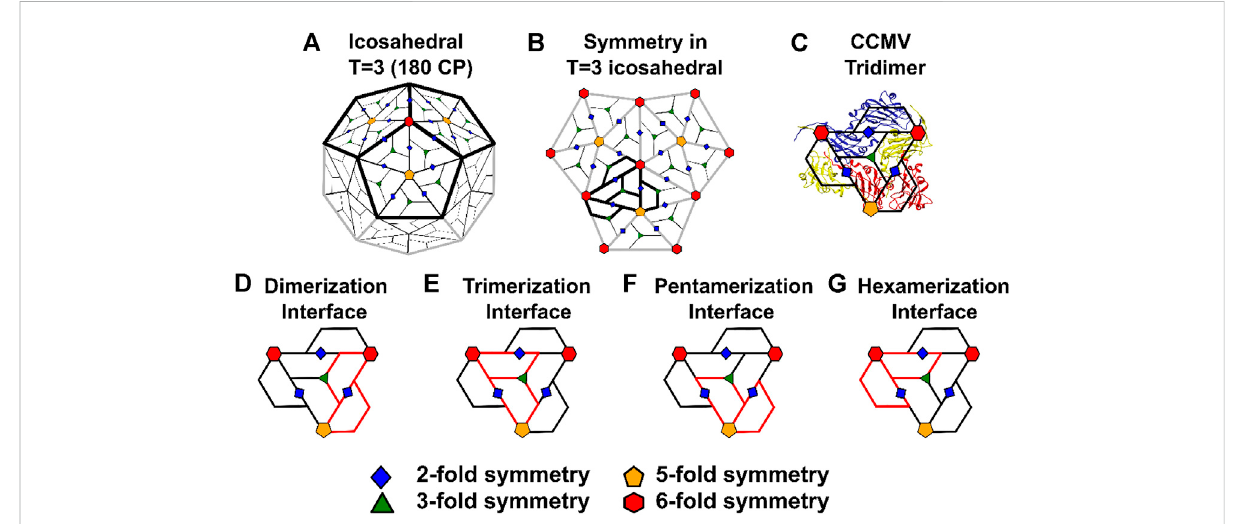
The arrangement of coat-proteins in T = 3 icosahedral viruses. A typical icosahedron consists of 20 equivalent equilateral triangular faces and 12 vertices. Each of the 12 vertices are shared by fi ve faces, resulting in 12 fi ve-fold axes of rotation symmetry (C 5 ). There are two-fold rotation symmetryaxes(C 2 )atthecenterofeachofthe30edgesandathree-foldaxis(C 3 )atthecenterofeachofthe fi vefaces.InaT=1icosahedralcapsid, each of the 20 triangular icosahedron faces are tiled by three equivalent coat-proteins (CPs). Thus, a T = 1 capsid has one CP in its icosahedral asymmetric unit (IAU), 20 × 3 = 60 CPs in total and exactly the same axes of rotation symmetry as the icosahedron. (A) A T = 3 capsid has three CP conformers(A,B,C)initsIAUleadingtoacapsidwith60×3=180CPs.Itisdrawnherebyplacingapentamer(threepentamersaremarkedwithdark boundaries) around each C 5 vertex (orange pentagon) of the original icosahedron. This pentamer is subdivided into 5 IAUs. The centers of the IAUs form 12 × 5 = 60 axes of quasi-three-fold rotation symmetry (QC 3 ; green triangles). There are 30 C 2 axes (originating from the icosahedron and between 2 C CPs; blue diamonds). Because there are three CPs per IAU, an additional 30 × 2 = 60 quasi-two-fold (QC 2 ; blue diamonds) axes of rotation symmetry are formed between the A and B CPs of two adjacent IAUs belonging to the same pentameric unit. Finally, the original 20 C 3 axes atthecenter ofeach faceare converted into quasi-six-foldaxesofrotation symmetry(QC 6 ,red hexagons) due to theextra symmetryinthetrimeric IAU.Thus,theT=3capsidconsistsof20QC 6 (redhexagons),12C 5 (orangepentagons),60QC 3 (greentriangles),30C 2 (bluediamonds)and60QC 2 (blue diamonds) axes. This representation scheme is preserved throughout the fi gures. (B) The three pentameric units marked with dark boundaries in (A) areenlargedandshownwithalltheaxesofrotationsymmetrymarked.Theregionmarkedwithdarkboundariesshowsthe6CPsthatformatri- dimericunit.ThisunitcontainsacentralIAU fl ankedbythreeadditionalCPsbelongingtoadjacentIAUs.ThesethreeCPsarerelatedtotheCPswithin the central IAU by (quasi-)two-fold rotation symmetry. Such tri-dimeric units contain every type of CP-CP interface that can be present in a T = 3capsid. (C) Thetri-dimericstructurefromthecapsidofCowpea ChloroticMottleVirus(CCMV ,Bromoviridae )withanoverlayofthetri-dimericunit from (B) . The three CP conformers from CCMV, A, B and C are colored red, yellow and blue respectively. For tri-dimer structures of representatives from all virus families, see Figure 2. (D – G) The various CP-CP interaction interfaces present in the tri-dimer. The two CPs which are part of the interactionaremarkedinred.TheredlinesegmentthatiscommontothetwoCPsrepresentstheinteractioninterface. (D) ThetwoCPs(CP2)which form the dimerization interface. There are three such interfaces in the tri-dimer. (E) The two CPs which form the trimerization interface. There are three such interfaces in the tri-dimer. (F) CPs which form the pentamerization interface (G) CPs which form the hexamerization interface. There are two such interfaces in the